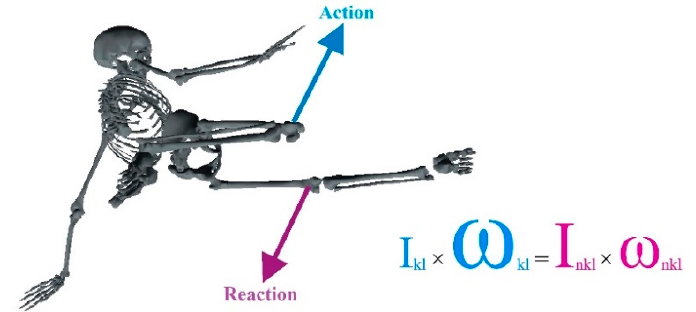
Figure 6. The asymmetric control of the legs during the airborne phase and their effects revealed by the Law of Conservation of Angular Momentum, i.e., the smaller the I, the faster the ω and vice versa. For training of the jumping side volley, one should pay attention to the following three aspects: kick power, accuracy, and